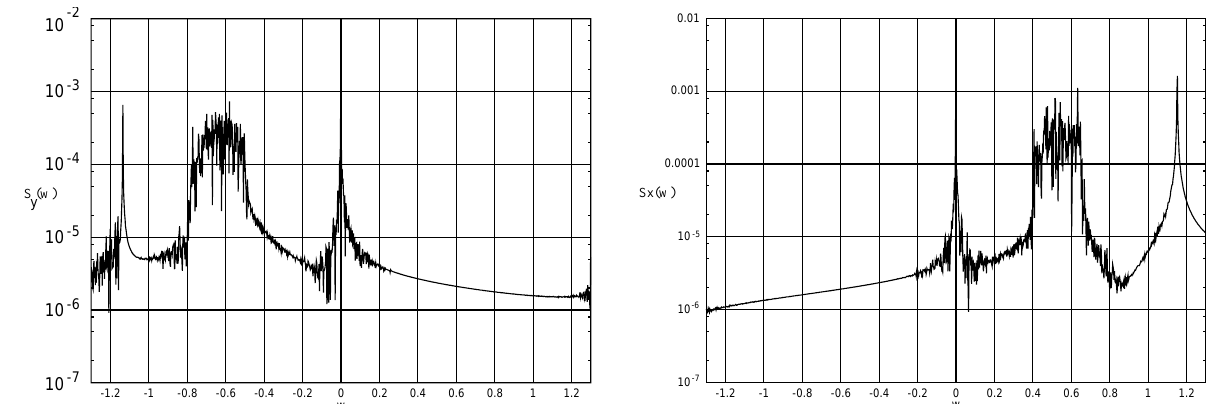
FIG. 9. Spectrum of the vertical (left) and horizontal (right) centroid motion for a long-range collision with horizontal separation L x (cid:1) 7.5 (in units of s x ) and no head-on collision (calculated over 2 17 turns with N (cid:1) 10 3 macroparticles). The horizontal axis gives the tune distance to the unperturbed tune Q in units of j : w (cid:1) (cid:2) n 2 Q (cid:3)(cid:1) j . The vertical axis gives the oscillation amplitude on a logarithmic scale. The tune shifts due to long-range collisions are of opposite direction in the two transverse planes. The frequency of the coherent p mode is at twice the incoherent tune shift.